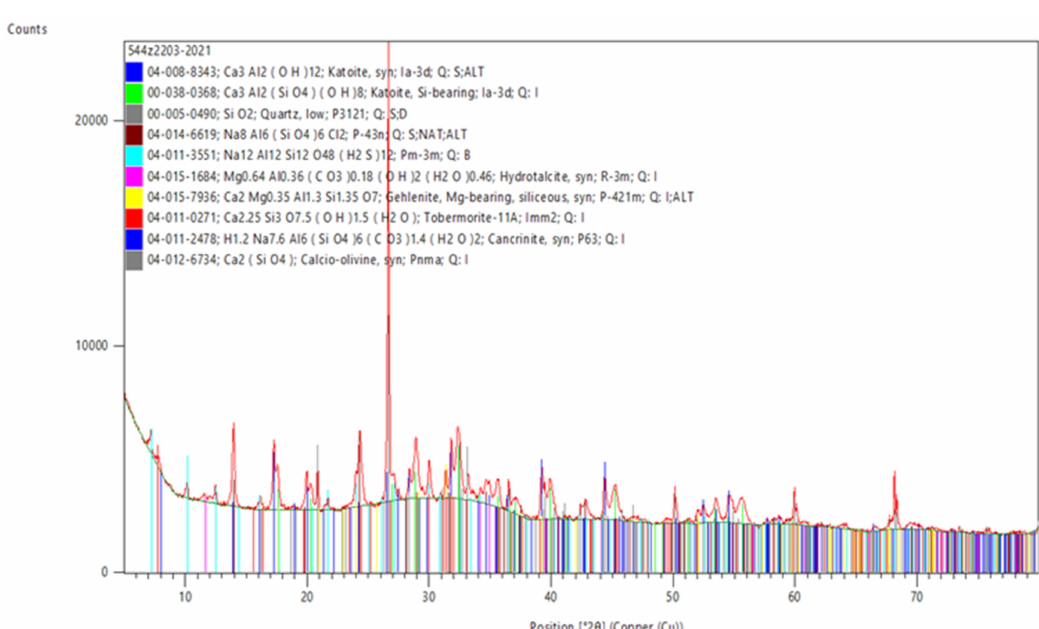
Figure 22. XRD pattern of M.6.1.z